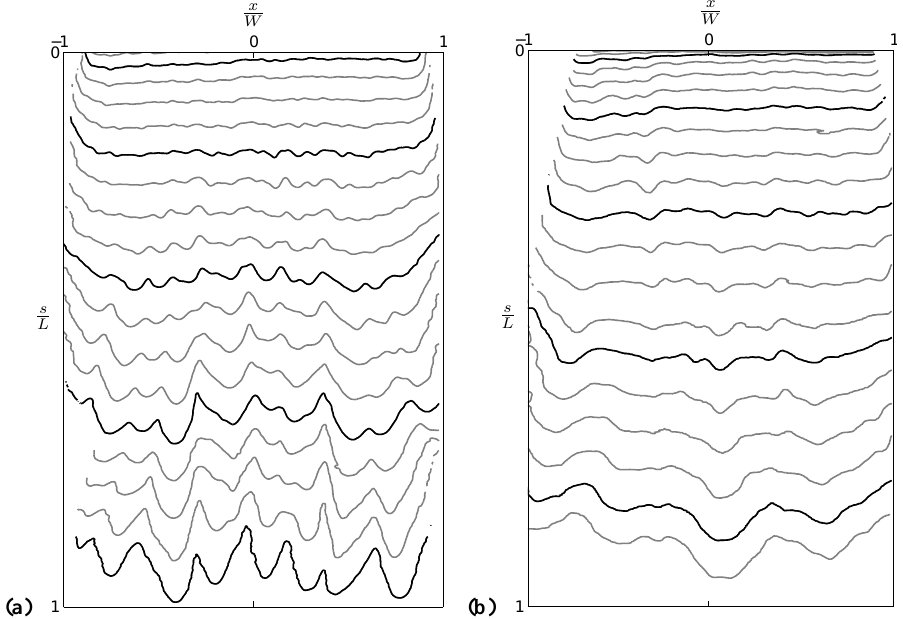
Fig. 5. (a) and (b) front profiles at 0.05s intervals taken from the flows shown in Fig. 3a and b, respectively. The highlighted profiles correspond to the position of the fronts at the times shown in Fig.